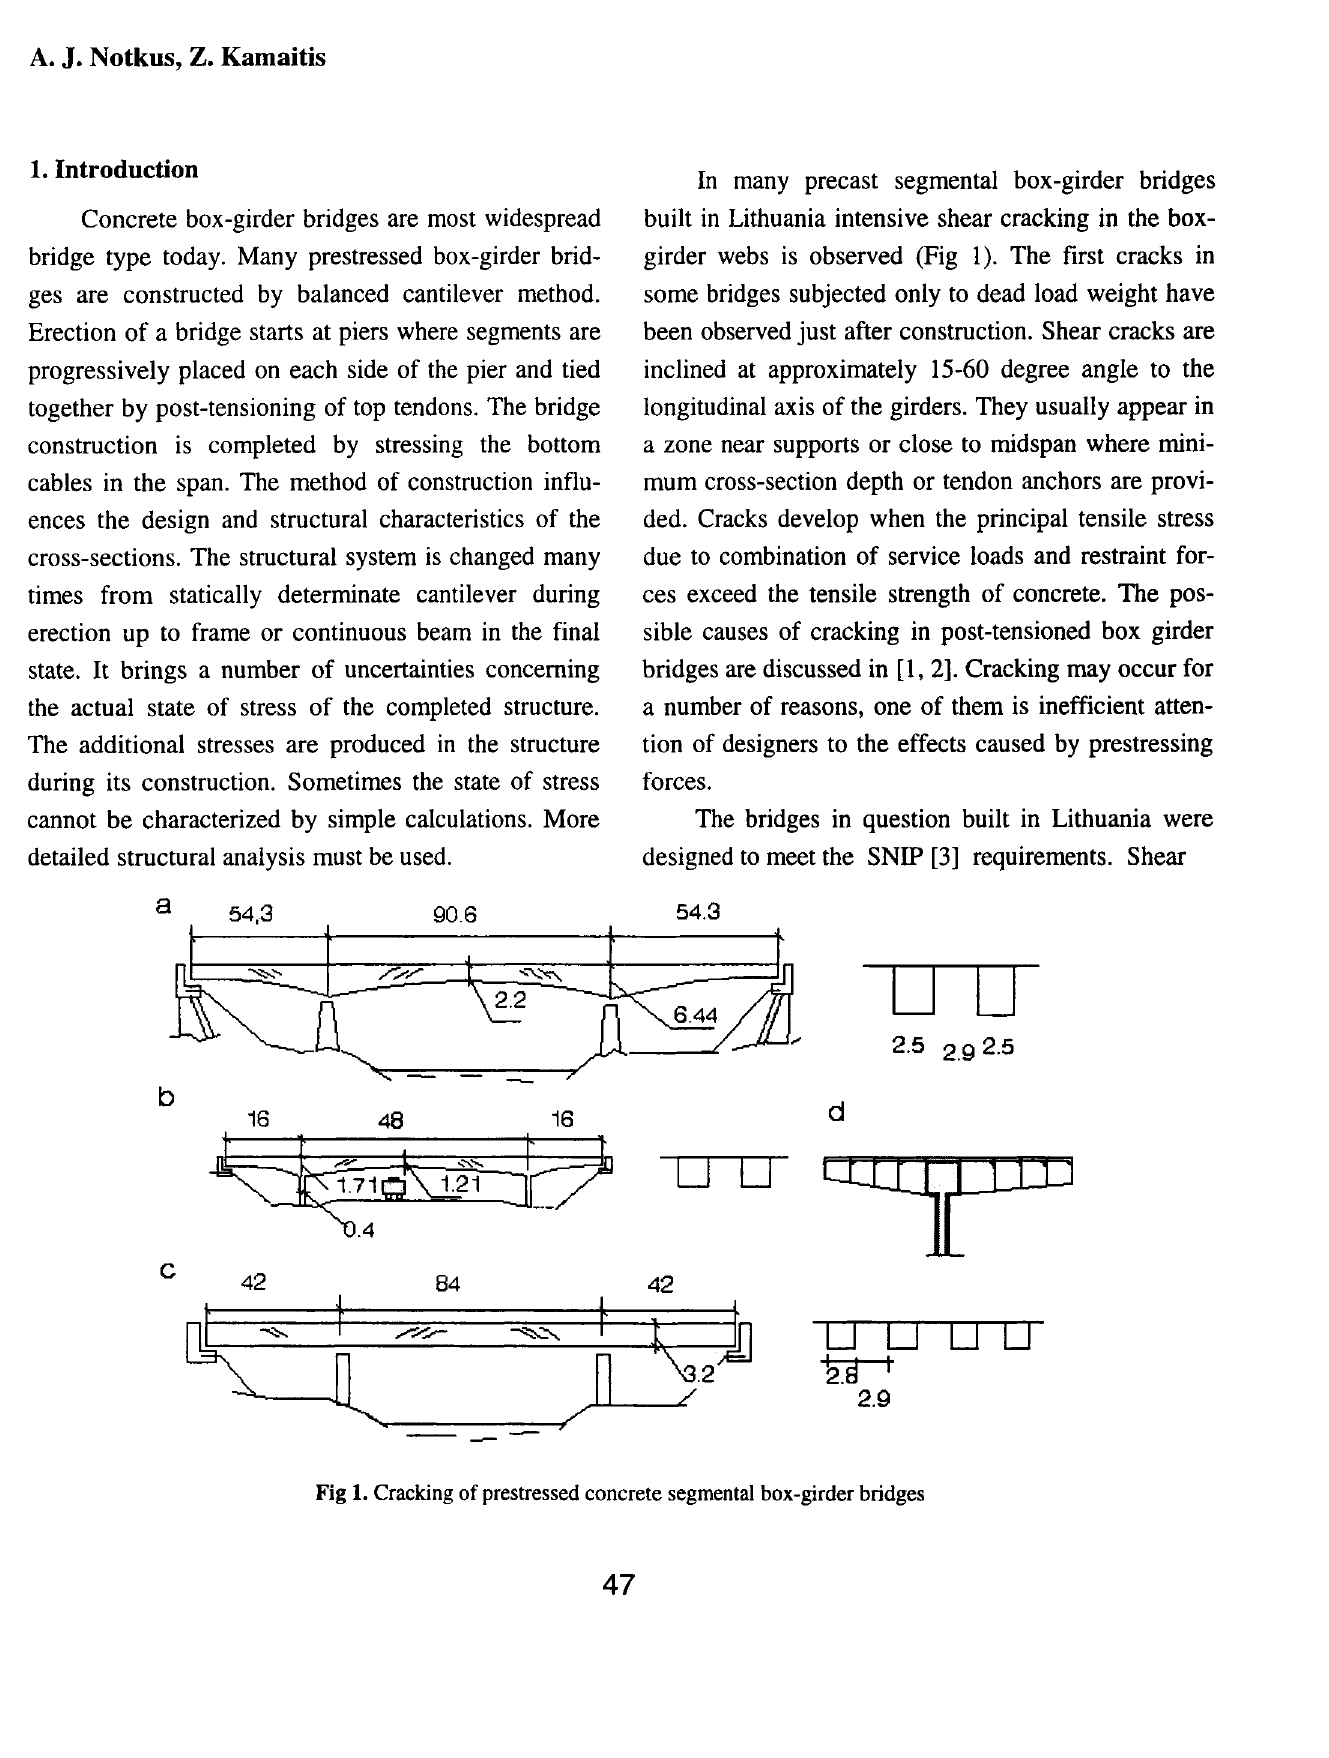
Fig 1. Cracking of prestressed concrete segmental box-girder